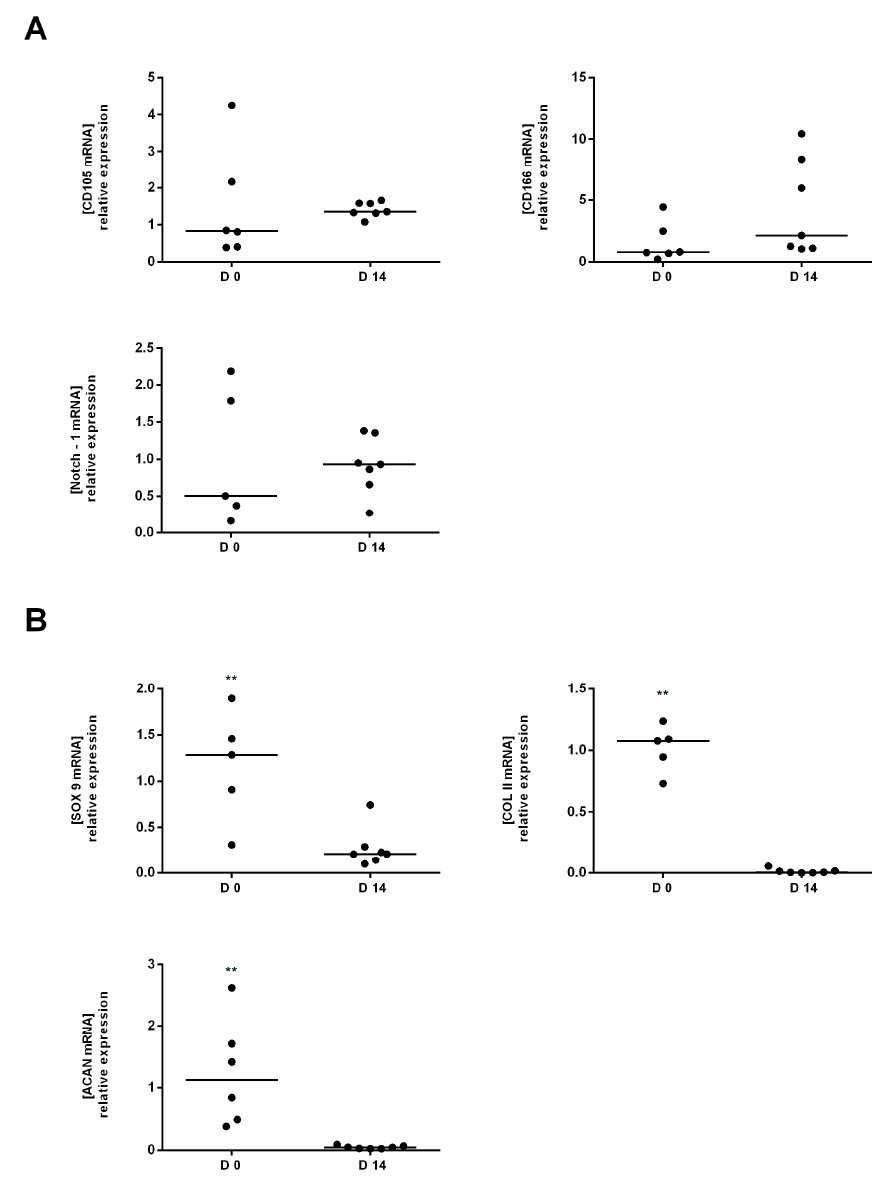
Figure 4. Comparative analysis of MSC and Chondrocytes markers between tissue (D0) and proliferated cells (D14) in severe OA. ( A ) The mRNA expression levels of CD105, CD166 and Notch 1 (MSC markers) at D14 versus D0; ( B ) The mRNA expression levels of Sox9, Acan and Col II (chondrocytes markers) at D14 versus D0. D0 is used as the control expression to normalized results. ** p < 0.01, Student’s t -test ( n = 8 in Mild OA, n = 6 in severe OA). Both proliferated cells (D14) derived from mild (Figure 5A) and from severe OA (Figure 5B) showed positive staining for 6 MSC markers; CD90, CD73, CD166, Nucleostemin, CD105 and Notch-